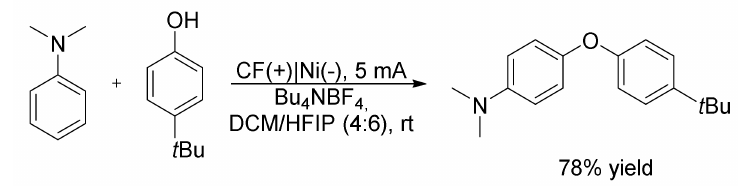
Scheme 21. Diaryl ether electrosynthesis.